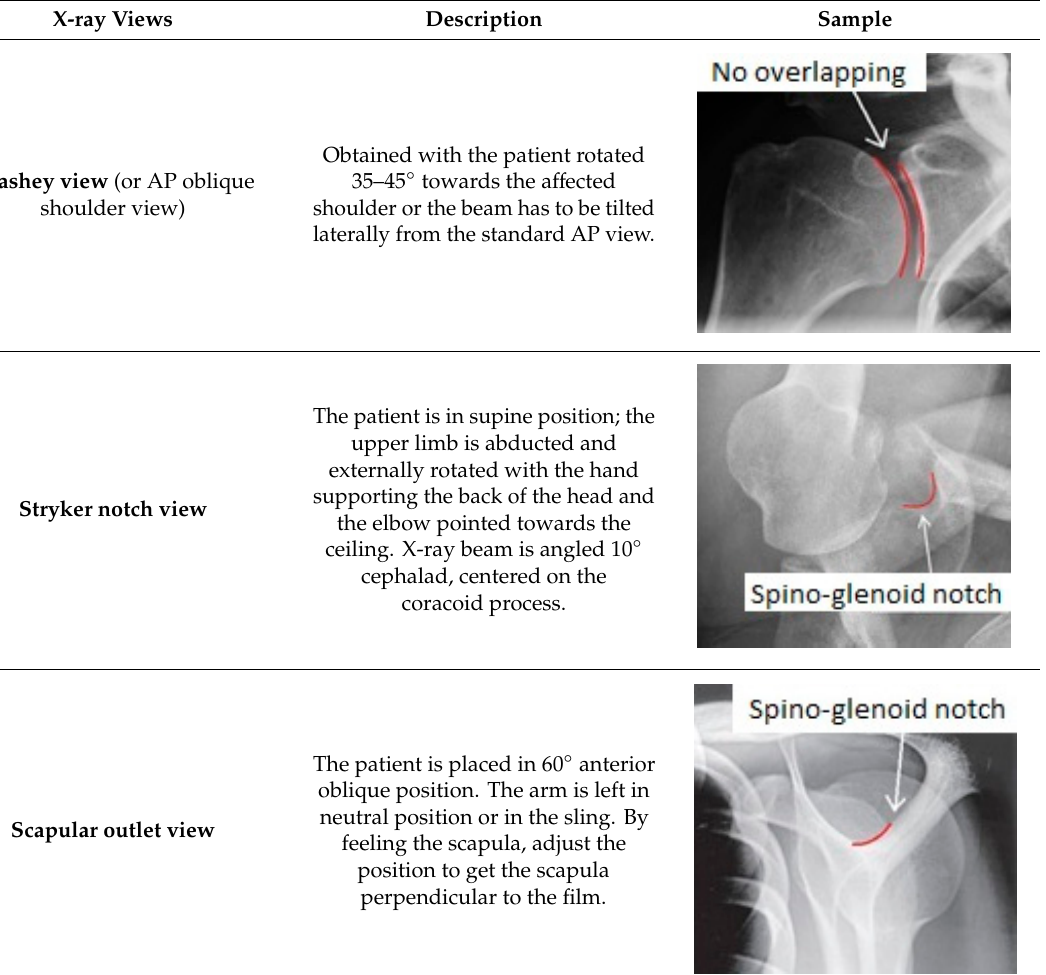
Table 2. Name, description and sample of the main specific x-ray views.